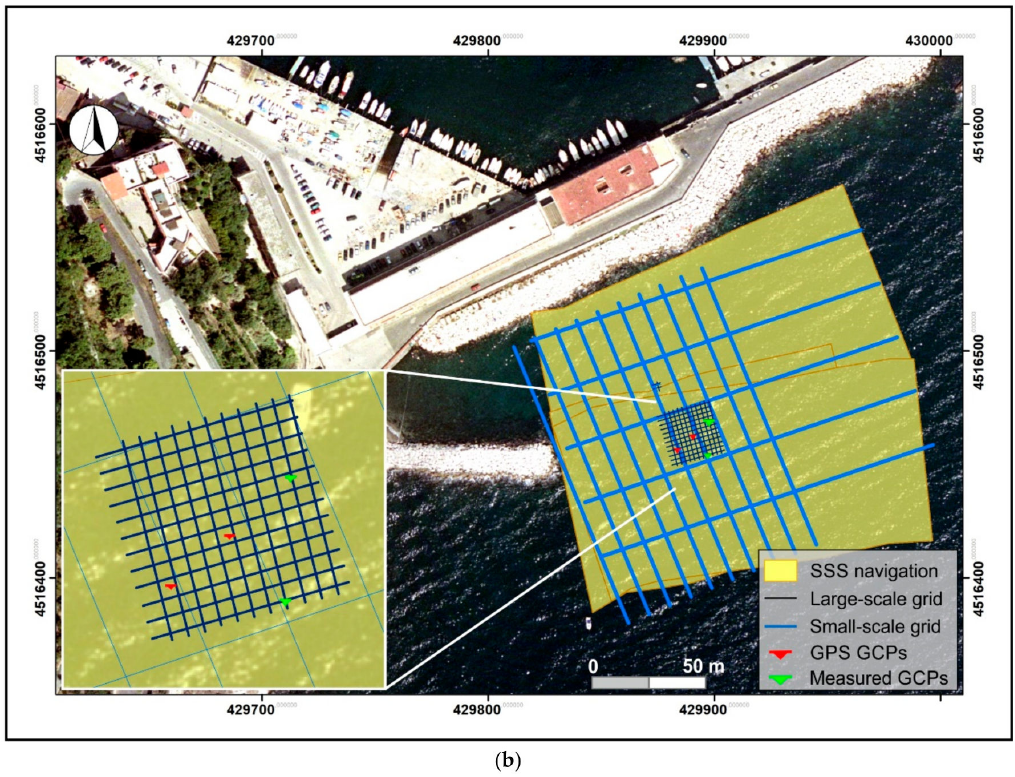
Figure 5. ( a ) Nisida aerial photo with a location map of the study area; and ( b ) navigation grids of morpho-bathymetric and photogrammetric